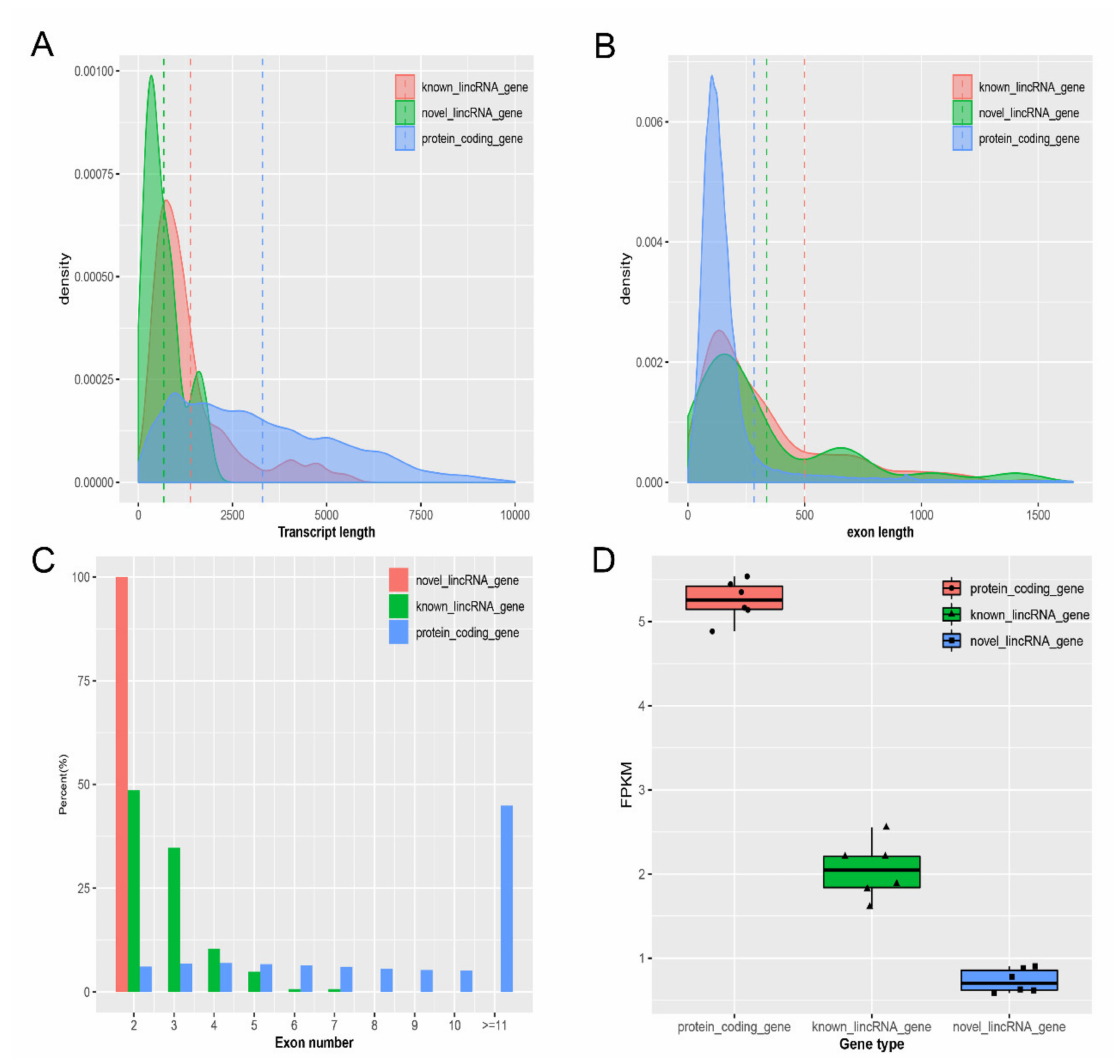
Figure 2. Characteristic of identified lincRNAs. ( A ) Comparison of transcript length; ( B ) comparison of exon length; ( C ) comparison of exon number; ( D ) comparison of expression